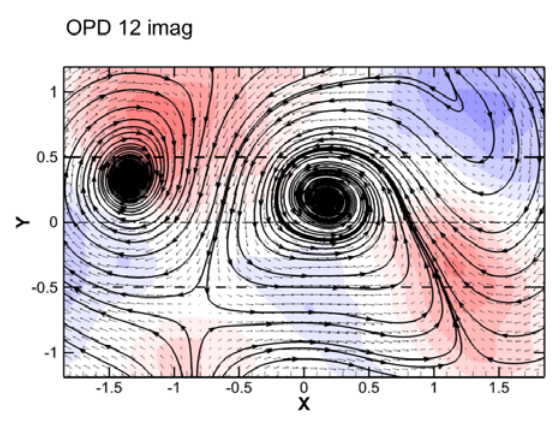
Fig. 7. Imaginary part of the OPD mode 14 topology .